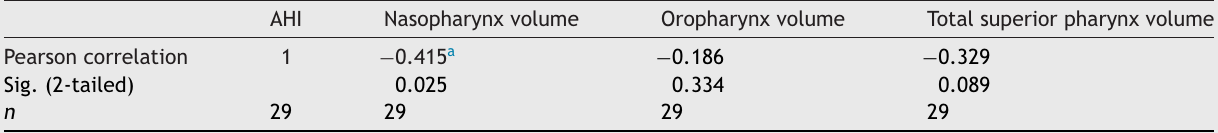
Spearman’s rank correlation coefficient between AHI and volume or pharynx segments.